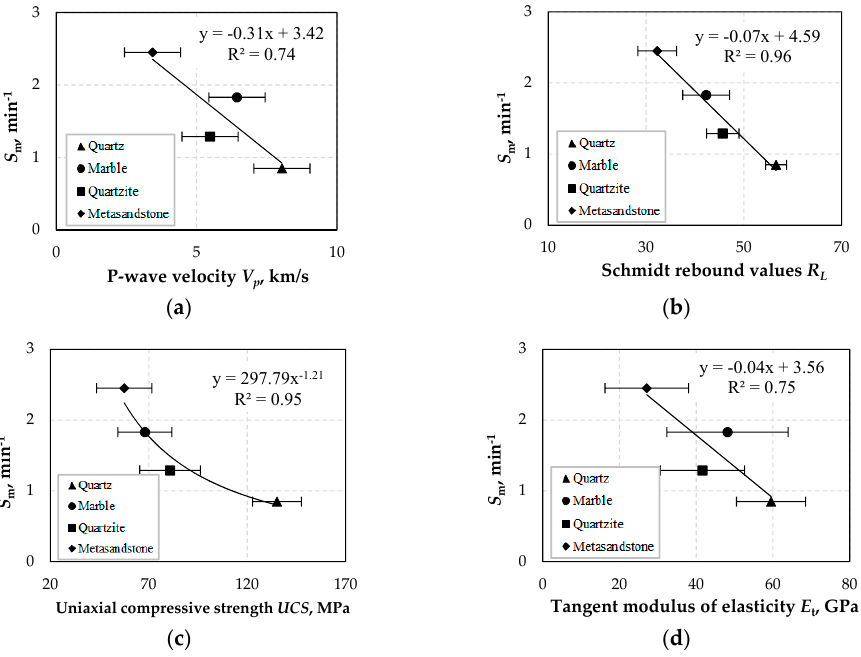
Figure 13. Correlations between maximum breakage rate S m and ( a ) P-wave velocity V p , ( b ) Schmidt rebound values R L , ( c ) uniaxial compressive strength UCS and ( d ) tangent modulus of elasticity E t ; horizontal error bars show standard deviation of the measurements.